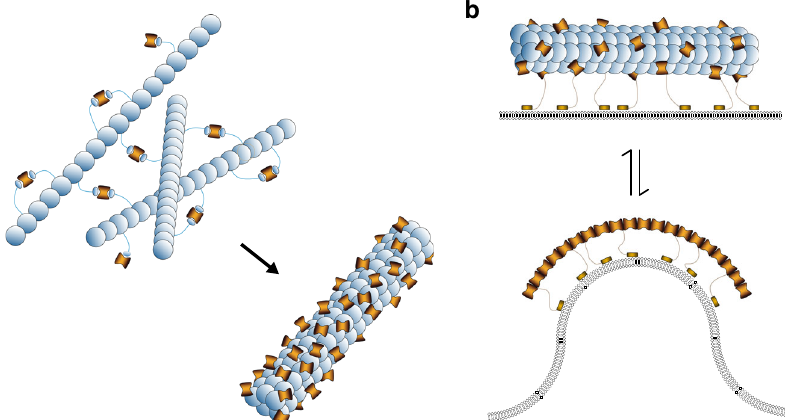
Fig. 6 Schematic model depicting the possible mode of action of SepF in the early stages of Z-ring assembly and septum formation. a Formation of the FtsZ-SepF complex in the cytoplasm leads to FtsZ fi lament bundling. b At the membrane, homodimeric SepF molecules bound to FtsZ fi laments would sustain membrane tethering (top), while membrane-bound polymerized SepF would play an active role in remodeling the lipid bilayer for septum formation